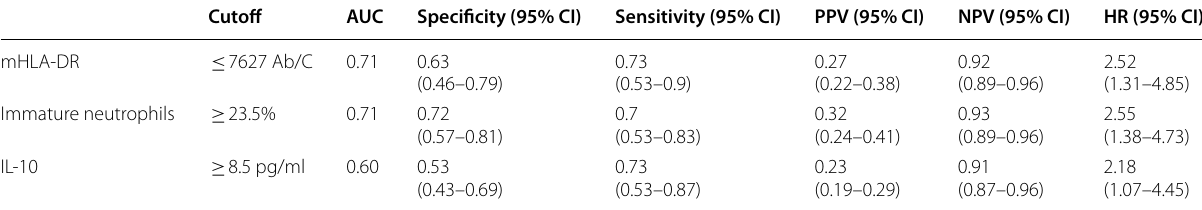
As measured in the cohort of interest ( n 189 ICU patients at days 5–7) = Values are presented with 95% confidence interval (CI) AUC area under the curve, PPV positive predictive value, NPV negative predictive value